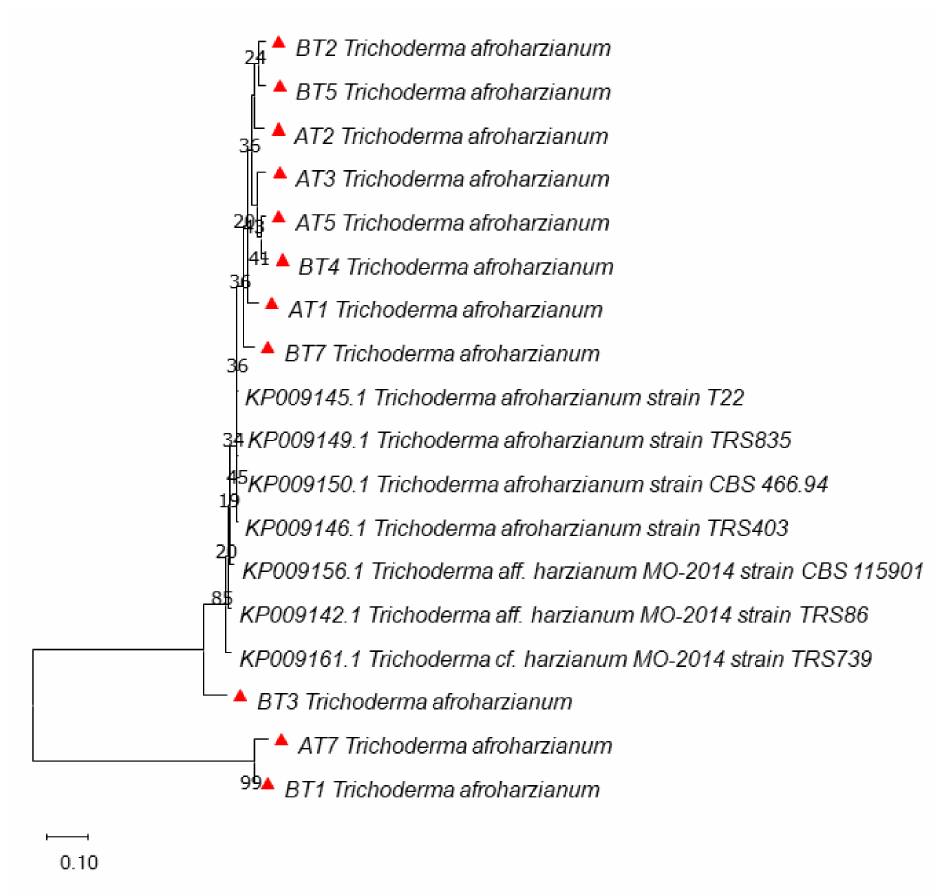
Figure 3. Phylogenetic relationship of Trichoderma harzianum using the region rpb2 (RNA Polymerase B) gene nucleotide sequence alignment using maximum likelihood method at 1000 replications for each bootstrap value using the MEGA 10.0, symbols red triangles in phylogeny represents our